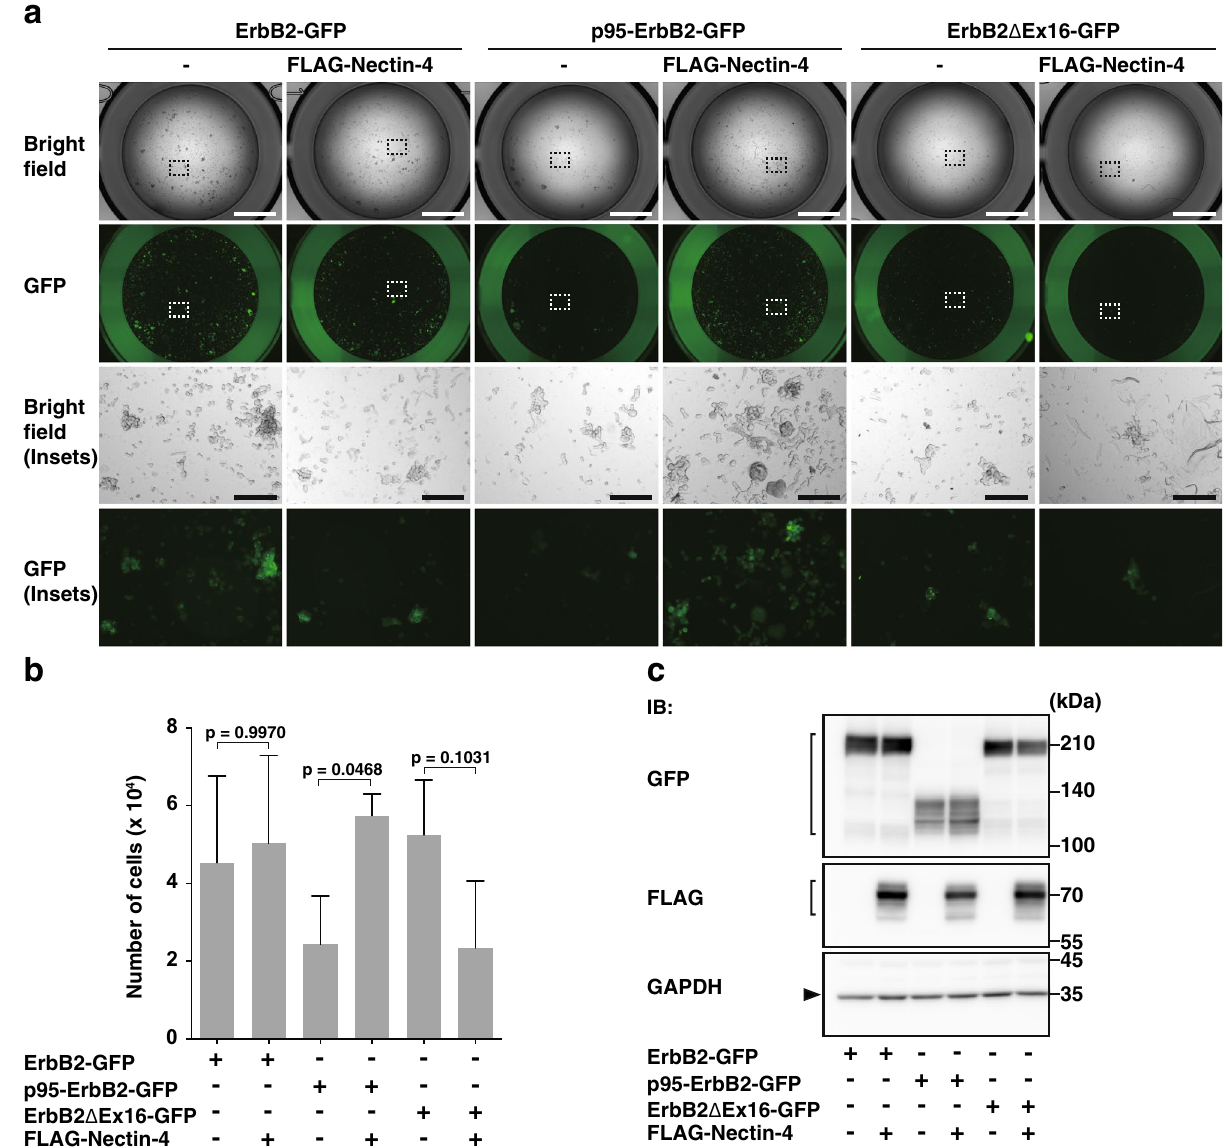
Figure 1. Enhancement of T47D cell proliferation by only the combination of nectin-4 and p95-ErbB2, but not by that of nectin-4 and either ErbB2 or ErbB2∆Ex16, in a suspension culture. ( a , b ) Enhancement of T47D cell proliferation by only the combination of nectin-4 and p95-ErbB2, but not by that of nectin-4 and either ErbB2 or ErbB2∆Ex16, in a suspension culture. The T47D cells stably expressing GFP-tagged ErbB2 or each of its splice variants with or without FLAG-tagged nectin-4 (FLAG-Nectin-4) were detached using Accutase. The cells were collected, their numbers were counted, and the same numbers of the cells were seeded in the serum- free medium with supplements on ultra-low attachment 6 well dish. After the incubation for 28 days, the cells were collected and transferred to ultra-low attachment 96 well dish for image acquisition. Then, the cells were re-collected and subjected to quantitative analysis by cell counting as shown in ( b ). The displayed images were acquired using a BZ-X710 microscope and its software BZ-X Analyzer (https:// www. keyen ce. co. jp/ produ cts/ micro scope/ fluor escen ce- micro scope/ bz- x700/ models/ bz- x710/) with BZ-H3A Advanced Application software (https:// www. keyen ce. co. jp/ produ cts/ micro scope/ fluor escen ce- micro scope/ bz- x700/ models/ bz- h3a/) for image connection. ( c ) Amounts of nectin-4, ErbB2, and its splice variant proteins. The T47D cells stably expressing GFP-tagged ErbB2 or each of its splice variants with or without FLAG-Nectin-4 were cultured for 72 h in an adherent culture. The cells were subjected to Western blotting using the indicated antibodies (Abs). All the cell lines used in the experiments were the bulk of collected cells and not singly picked-up clones. Arrowhead and square brackets indicate each of the proteins. The displayed blots were cropped, and the full-length blots are shown in Supplementary Figure S3. Bars indicate the means ± S.D. of five independent experiments and the actual P values for each test are shown. Scale bars 2000 μm or 200 μm (insets). IB, immunoblotting. Representative results (images) from three independent experiments were